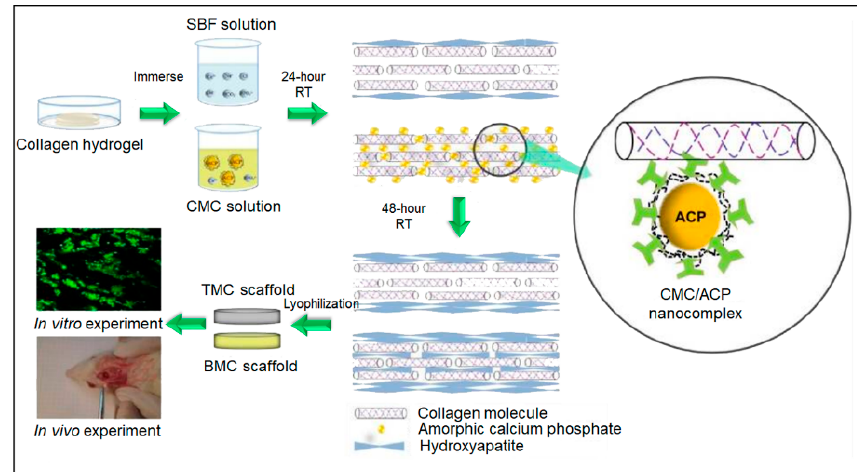
Figure 4. Experimental scheme of the hydroxyapatite formation on the collagen hydrogel scaffold by simulated body fluid (SBF) with the carboxymethyl chitosan (CMC). The biomimetic mineralized collagen (BMC) and traditional mineralized collagen (TMC) were used to repair critical sized cranial defect in a rat model. Adapted with permission from [55].